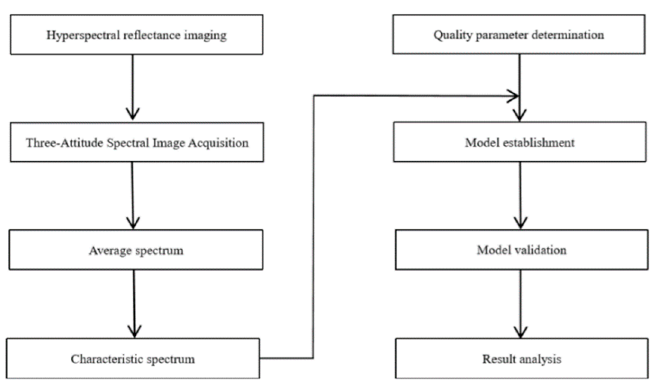
Figure 1. Hyperspectral imaging system.